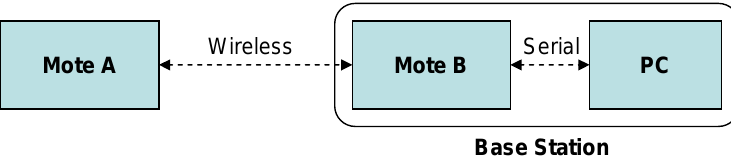
Figure 7. Experimental setup with two motes and a